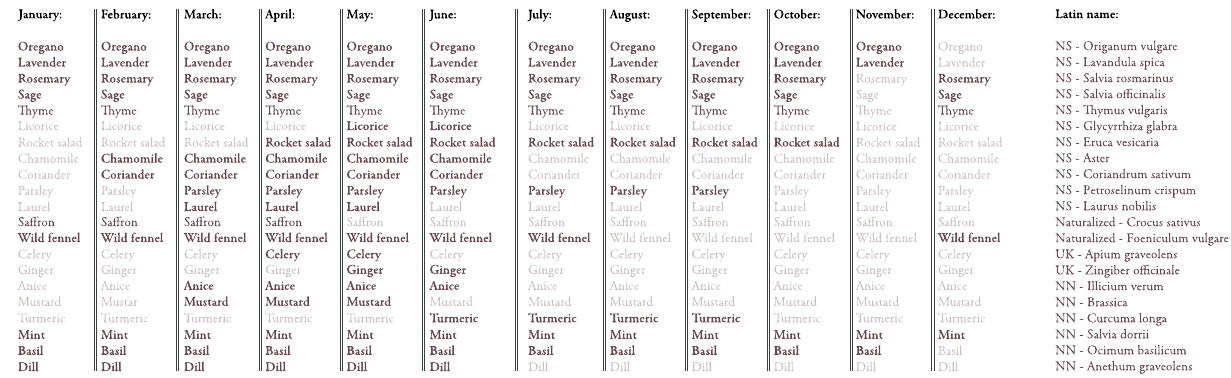
Figure 6. Period of cultivation of aromatic plants. NS: native species; UK: unknown; NN: not native [12].